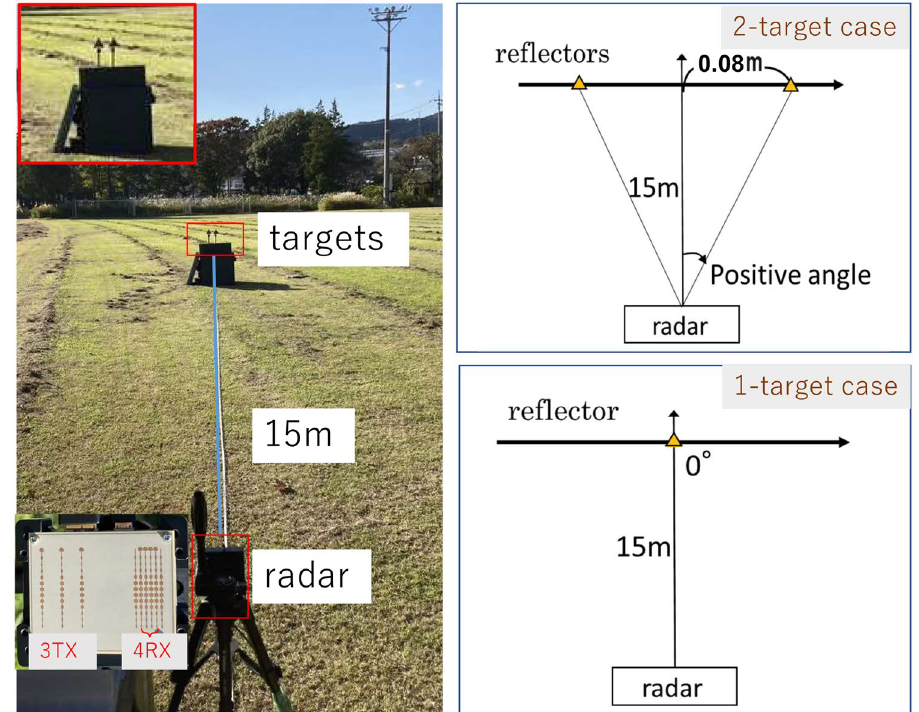
Figure 9. Experimental environment for horizontal angle